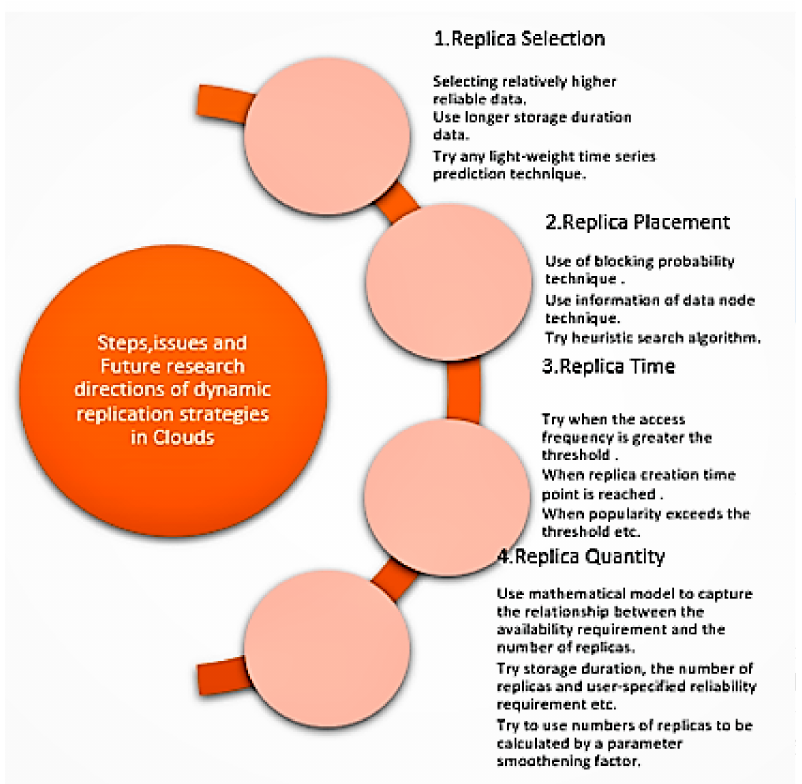
Figure 7. Issues and future research directions of dynamic replication strategies in